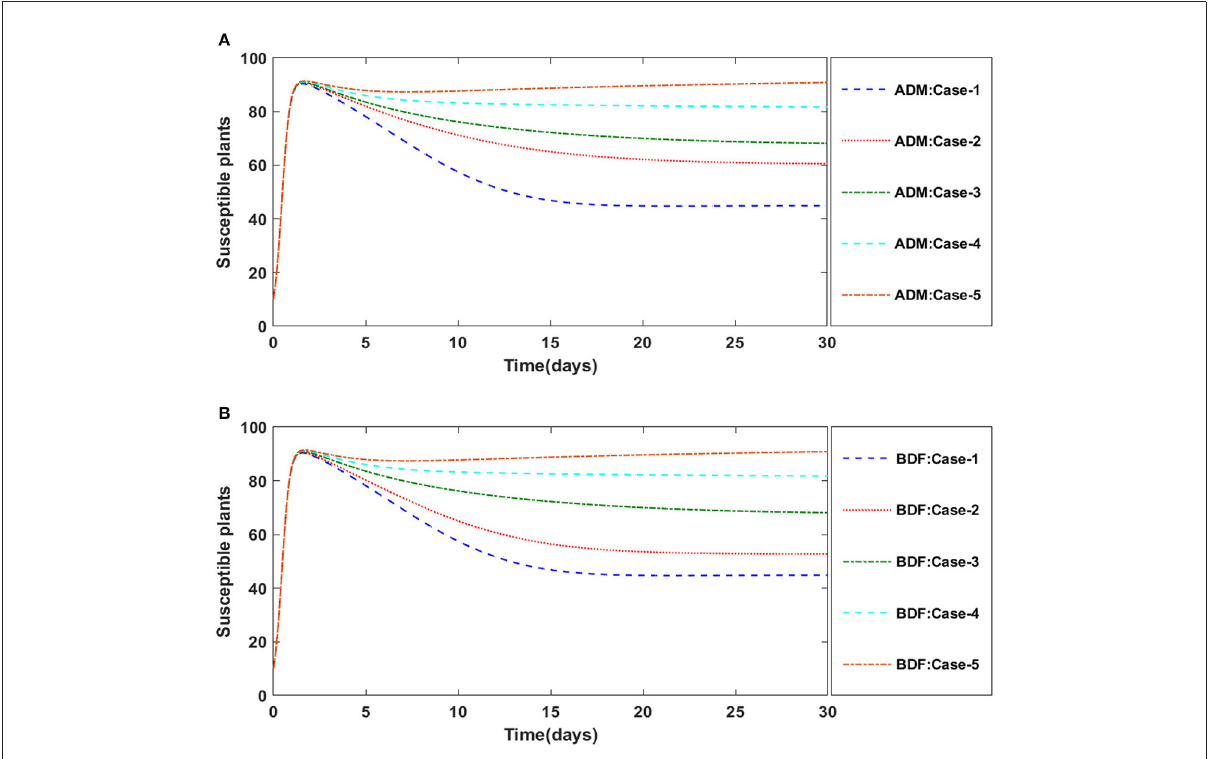
FIGURE22 (A) Dynamics of susceptible plants for the varition in r using ADM for model B2. (B) Dynamics of susceptible plants for the varition in r using BDF for model